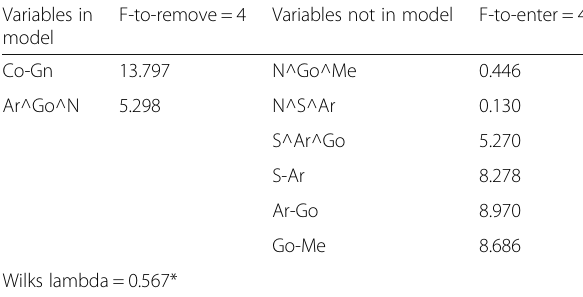
Table 3 Stepwise variable selection procedure Variables in